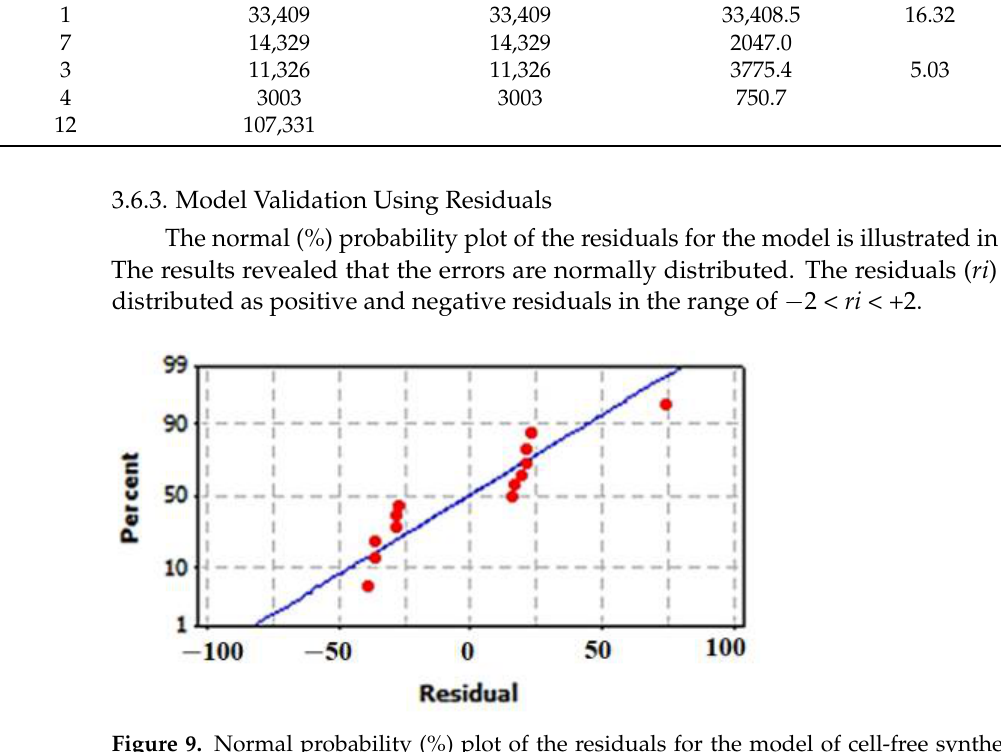
Figure 9. Normal probability (%) plot of the residuals for the model of cell-free synthesized human man TNF- α TNF-α.